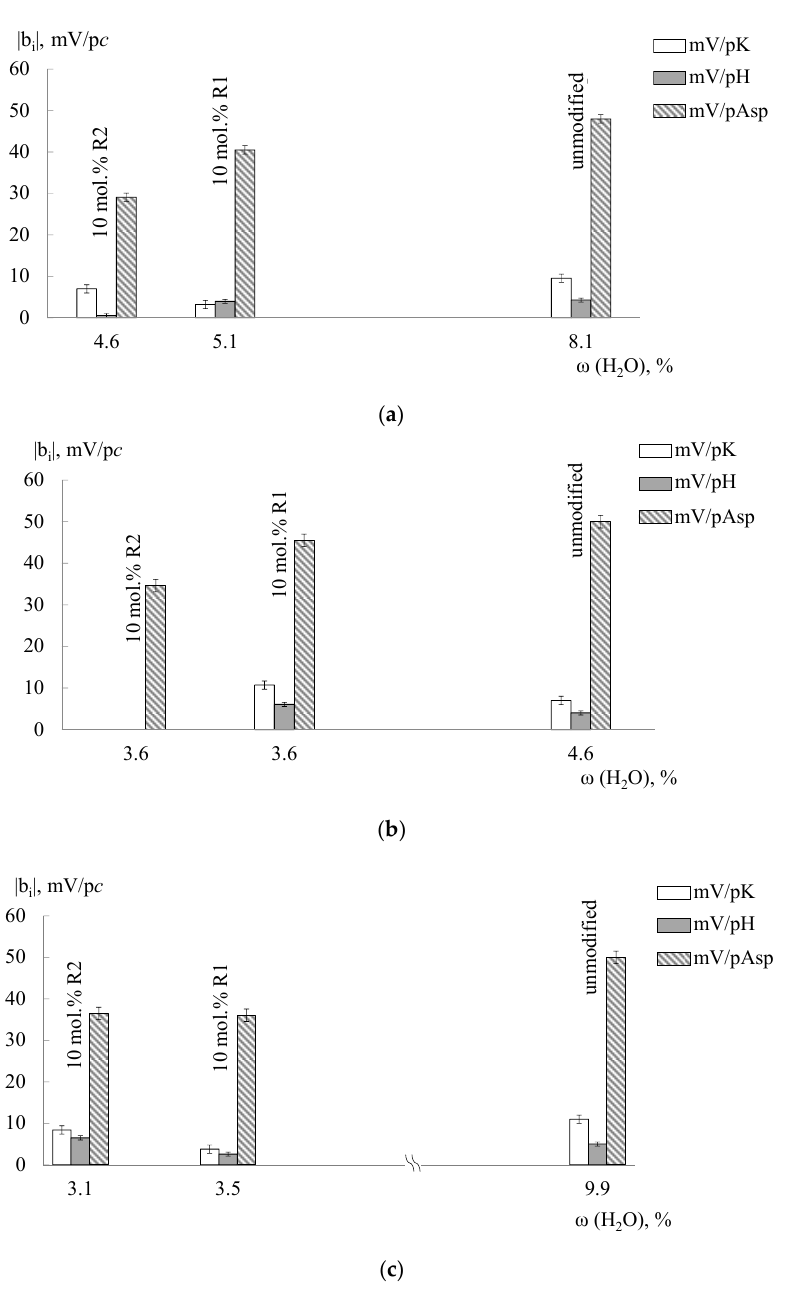
Figure 7. The dependence of DP-sensors’ sensitivity coefficients to ions in the Asp + KOH solutions (pH 3.99–8.20) on the water uptake (in the K + -form) of Nafion (extrusion) + SiO 2 (R) membranes, without treatment ( a ), treated at the RH = 60% , t = 95 °C ( b ) and t ht = 120 °C ( c ).